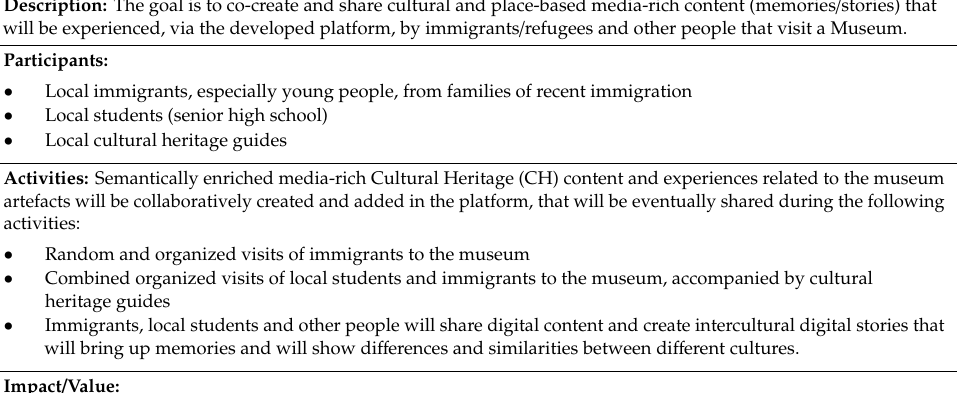
Table 1. Use case of creating interactive cross-cultural art stories at a